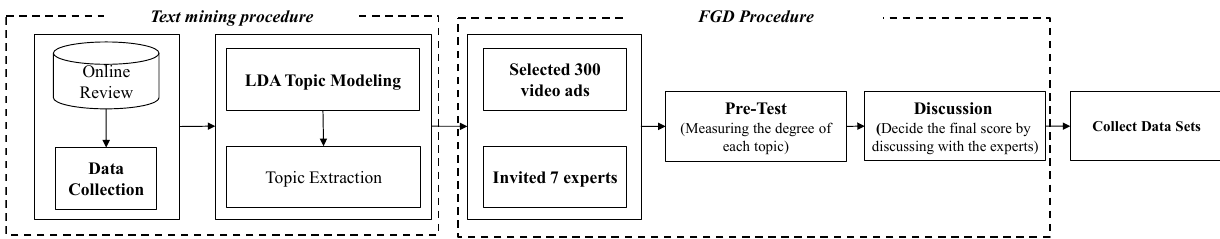
Figure 2. Exploratory Study Procedure.